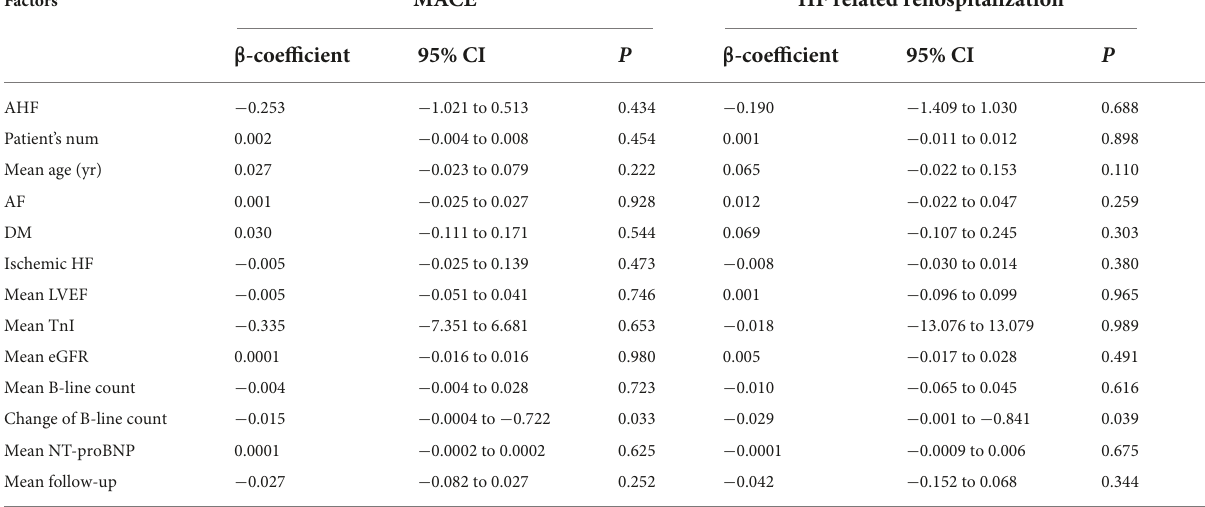
TABLE 4 Meta-regression analysis of baseline data and clinical